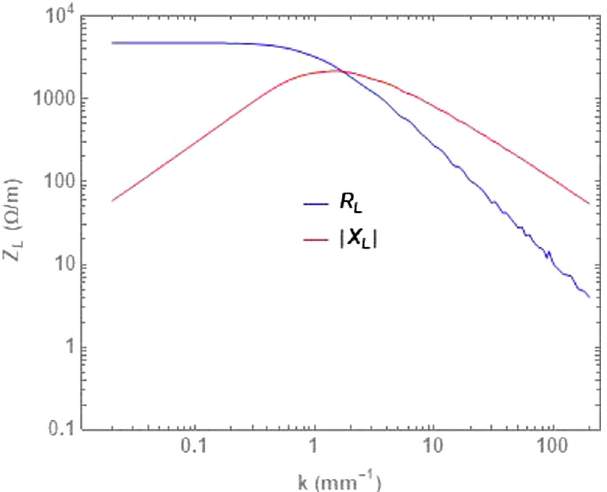
FIG. 39. The longitudinal short-range wakes for the represen- lines.FIG. 37. The real R and absolute value of the imaginary j X tative cells (cells 1, 15, 25, 30, 35, 45, and 60) are calculated via x x j parts of the longitudinal impedance of the mid cell of the XARA the CFD code (solid) and the fitted wakes (dashed) found by structure as calculated by the CFD code for Im ð k Þ ¼ 0 . 5 mm − 1 Eq. (50). Also shown is the average of the fitted wakes of the cells which approximately represents the full structure.